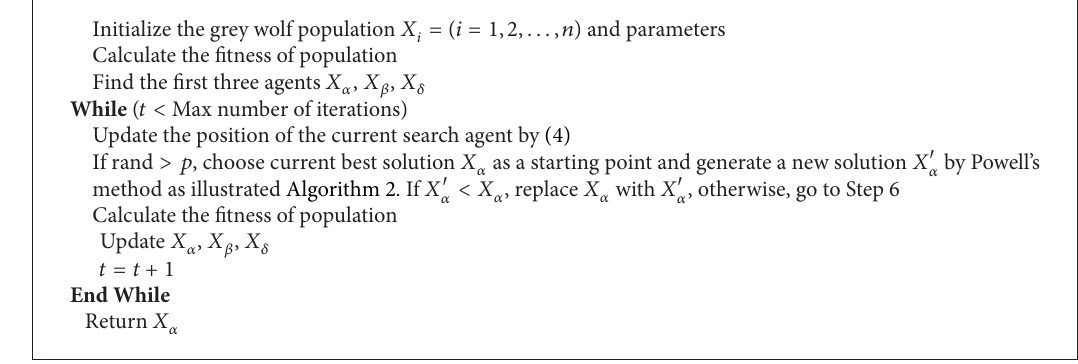
Algorithm 3: PGWO algorithm. Table 1: Benchmark